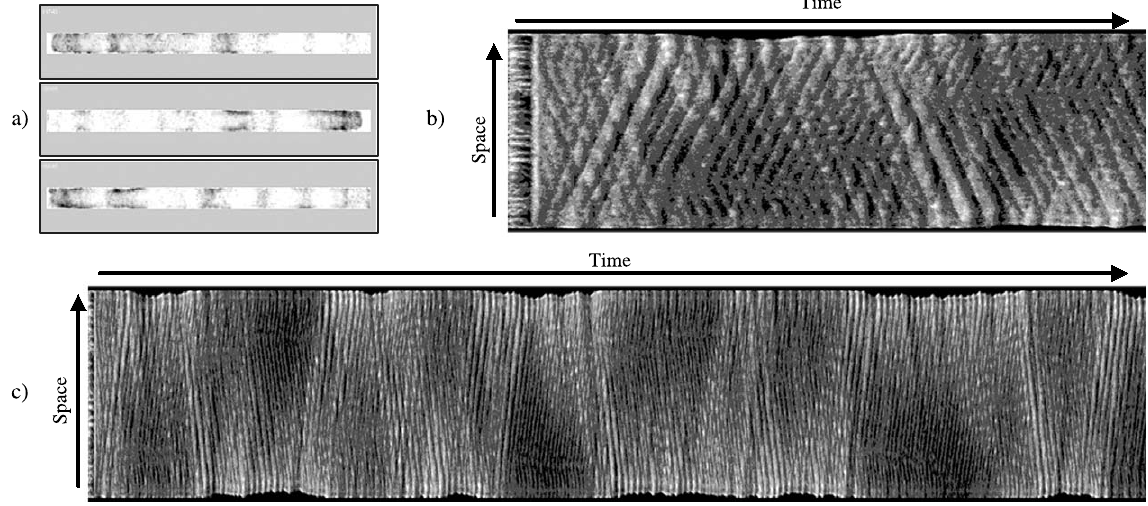
Fig. 19. Complex second-order oscillations caused by bulk drift in closed path environments. a) Pulsatile oscillations at different sides of a closed chamber, b) Initial phase of space-time plot showing initiation of oscillatory behaviour and competition between oscillatory domains, c) long term (20,000 steps) space-time plot showing second order oscillations as bulk particle positions oscillate from one side of the chamber to the other. Dark regions at either side of plot indicate periods of second-order oscillations.